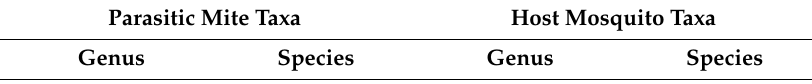
Table A2. Parathyas water mite species and the mosquito species they parasitize